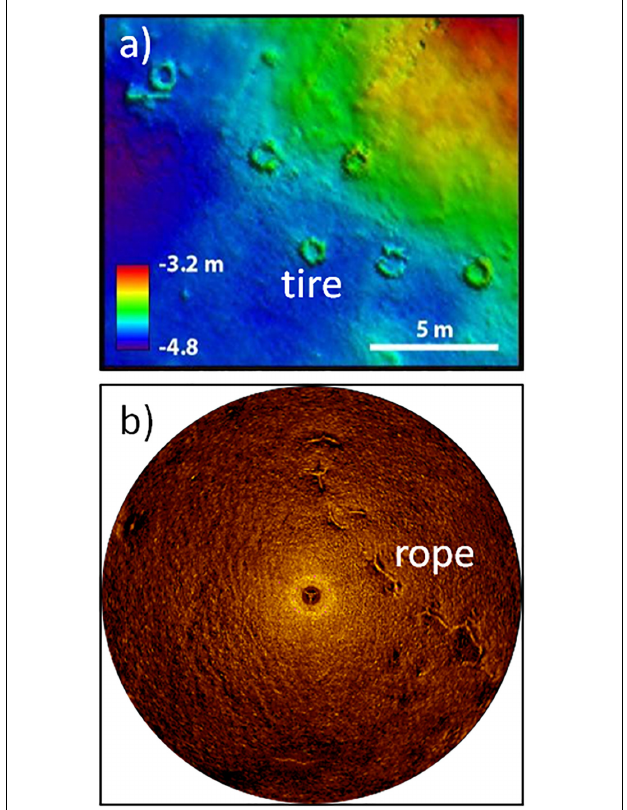
FIGURE 2 | (a) Example of tires on the Venice Lagoon seafloor mapped with a high-resolution MBES (modified from Madricardo et al., 2019). (b) Example of rope fragments on the seafloor mapped with HRSS during the “GHOST”